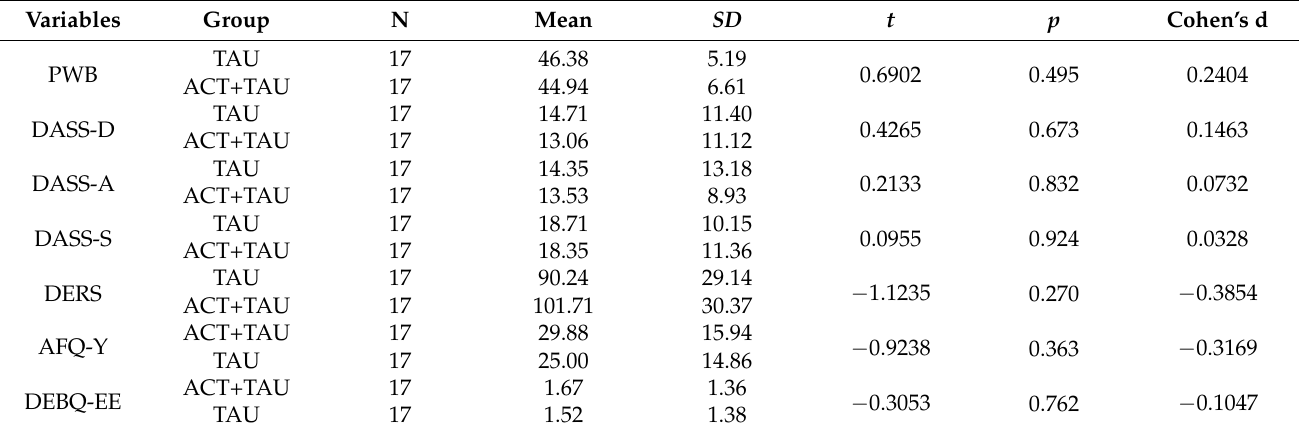
Table 1. Pre-test participant characteristics divided by treatment groups (ACT+TAU vs.